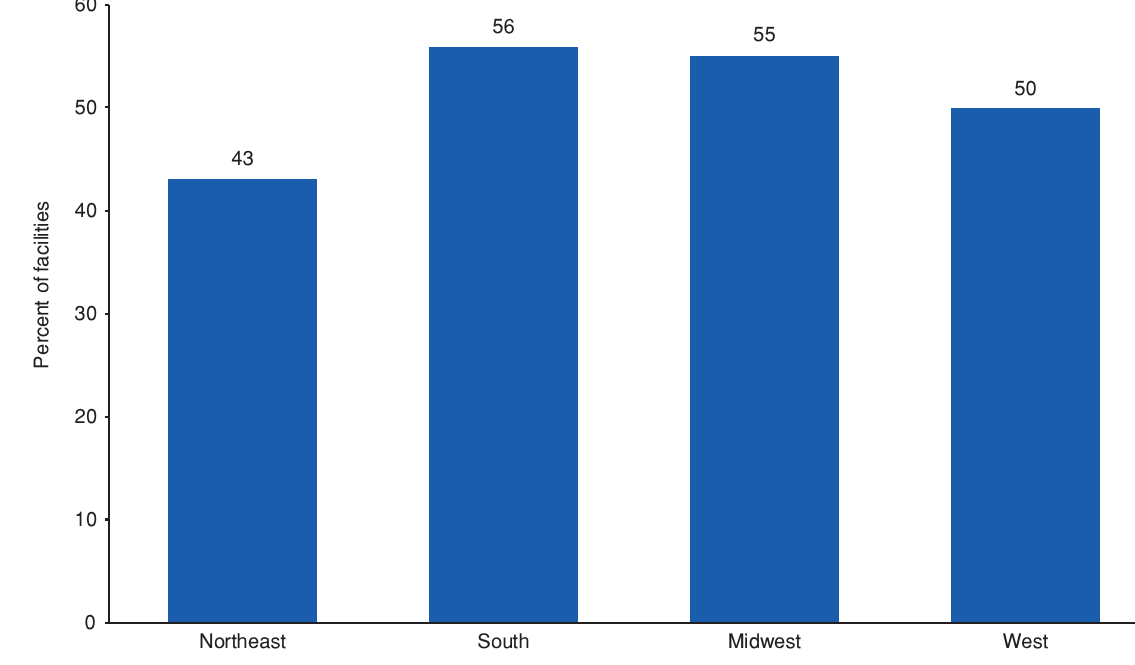
Figure 13. Mental health treatment facilities offering treatment services in sign language for the deaf and hard-of-hearing, by region: